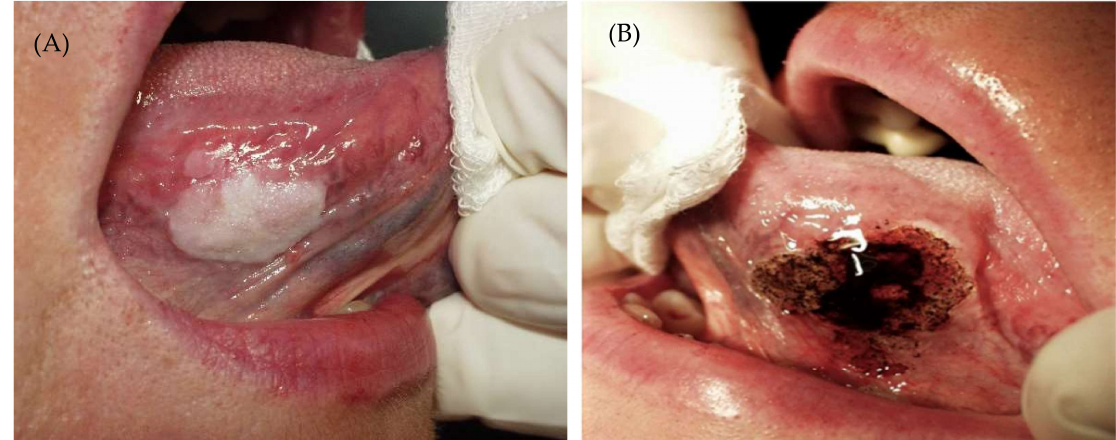
Figure 1. ( A ). Oral leukoplakia Before CO 2 . ( B ) Immediately after treatment.